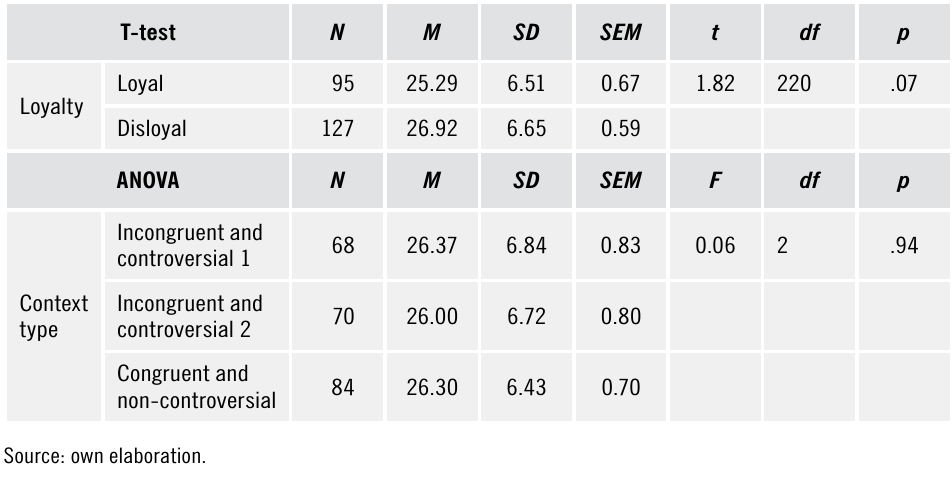
Table 1. Change in age by independent